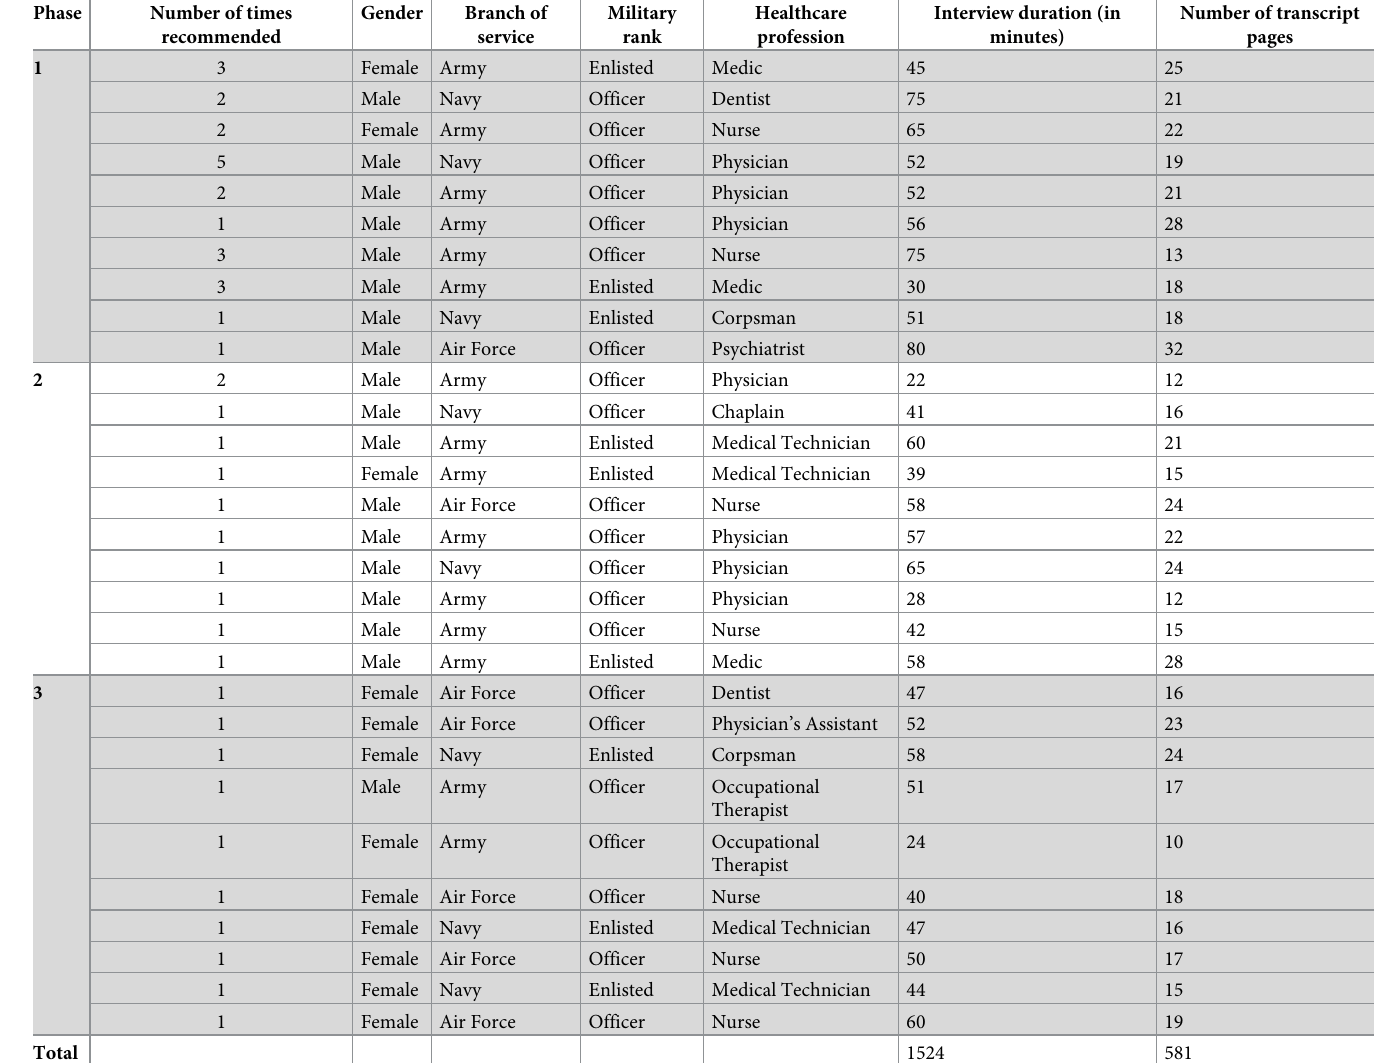
Table 1. Demographic description of